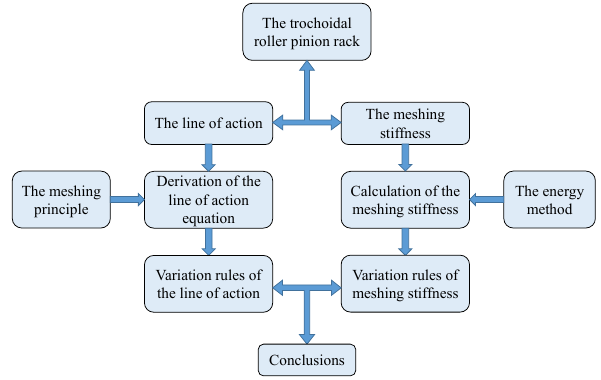
Figure 1. The flowchart of research content.